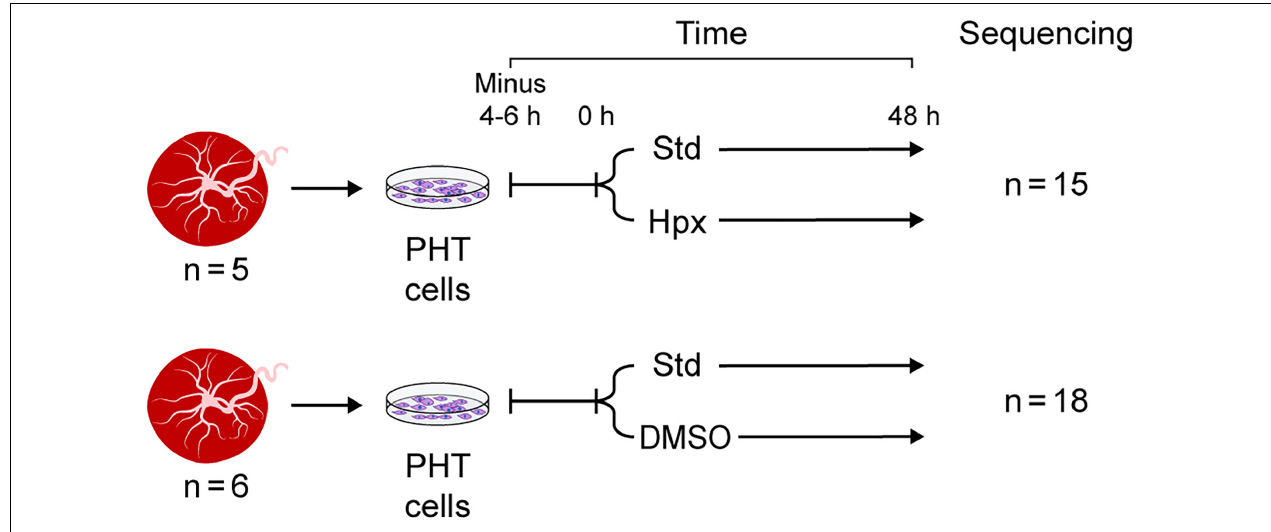
FIGURE 1 | Experimental design. Note that PHT cells were sequenced at 0 h (4–6 h after plating, serving as control) and at 48 h in standard culture conditions or in the two experimental exposure sets: hypoxia (Hpx) or DMSO added to the culture medium.